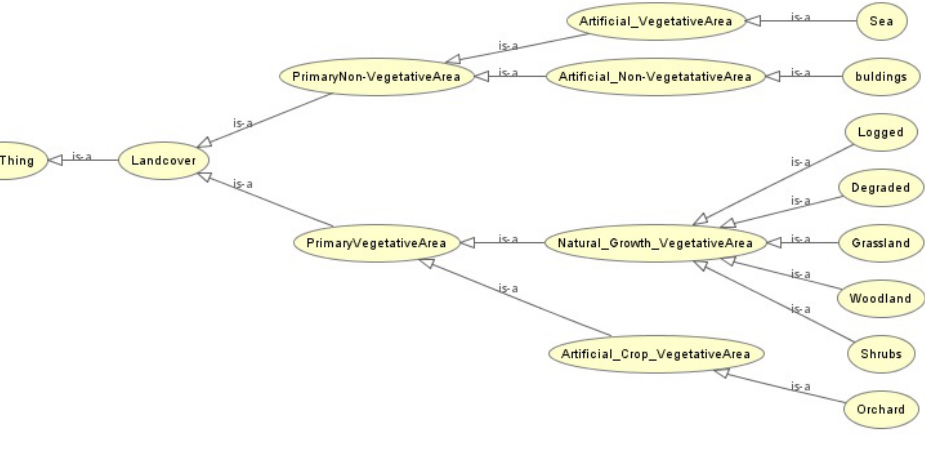
Figure 4. Ontology of Forest